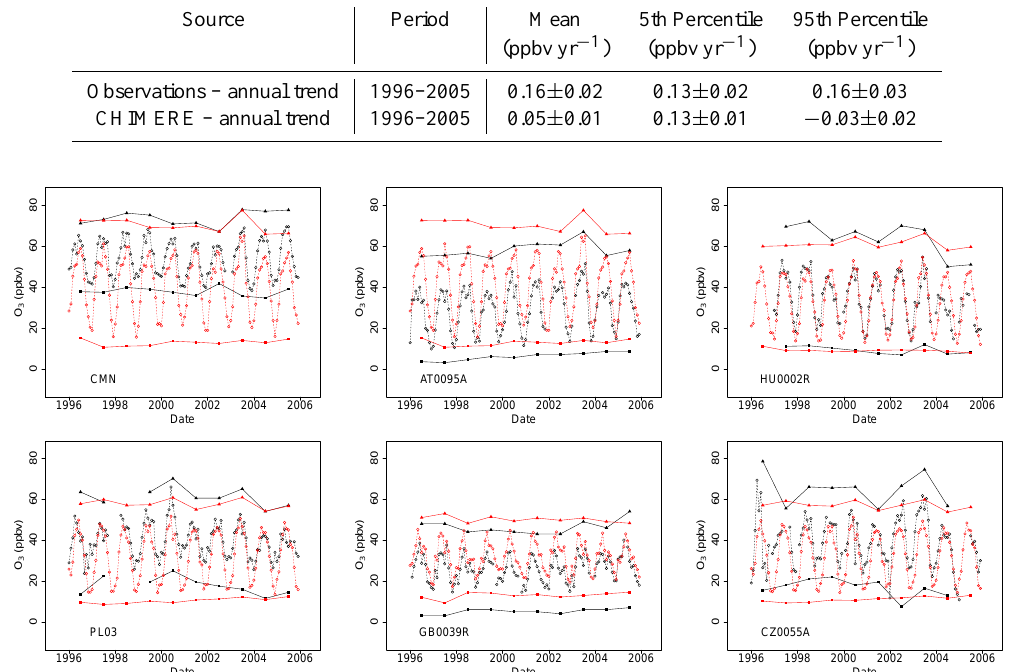
Table 4. Summary of the average European annual trends (ppbvyr − 1 , with 2 σ error) from observations at all 158 sites in Fig. 1 and the CHIMERE simulation.